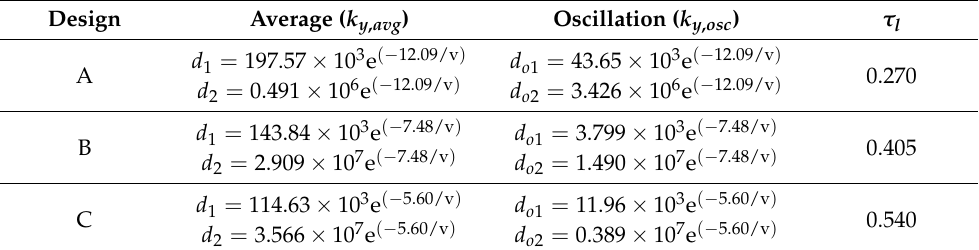
Table 8. Coefficients of the guidance stiffness (average and oscillation).